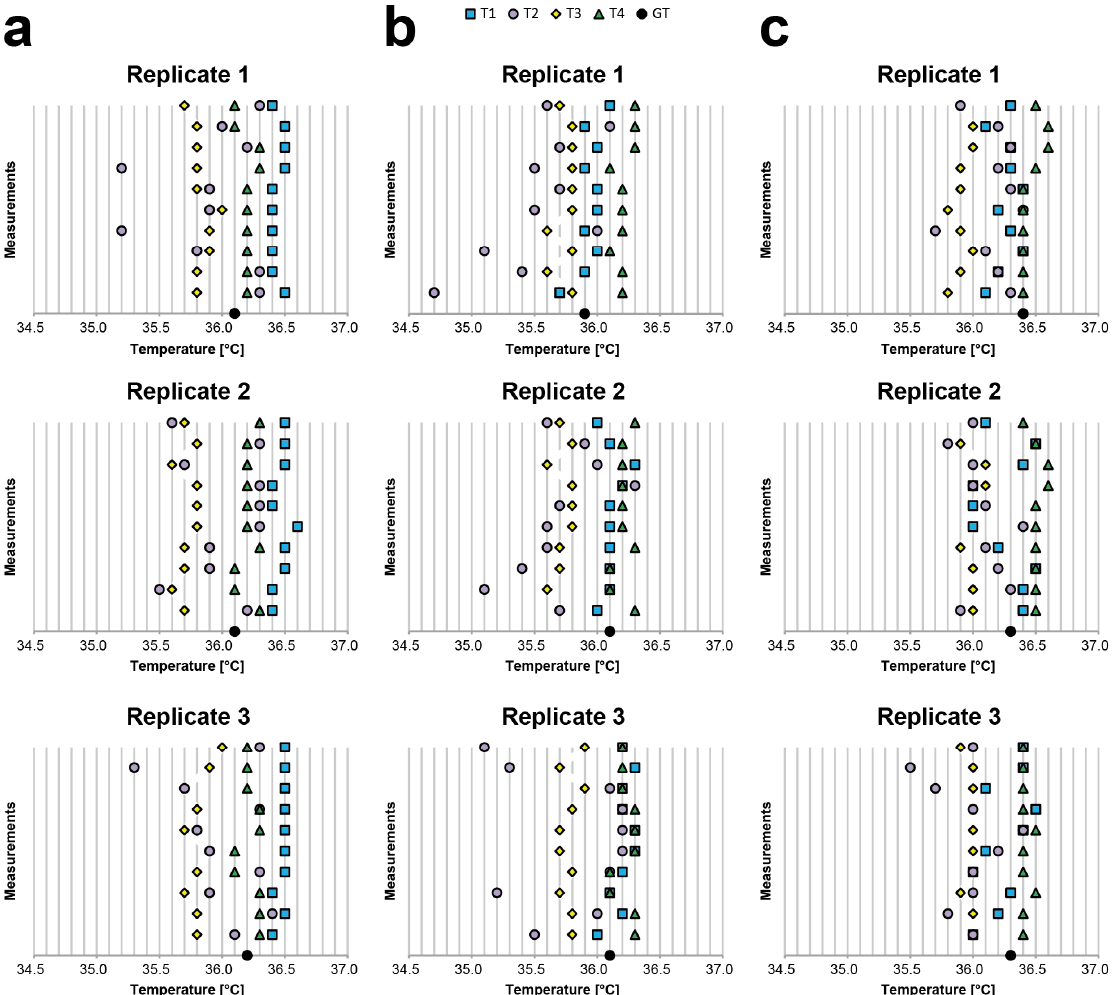
Figure 3. Visual representation of the temperature data (reported on the x -axis in °C) collected during the inter- and intra- rater reliability experiment. For each replicate, 10 measurements for each thermometer were acquired while always acquiring only one measurement at a time for each to ensure a slightly different distance and angle between the measurements acquired using the same thermometer; ( a ) Subject 1, ( b ) Subject 2, and ( c ) Subject 3 values.